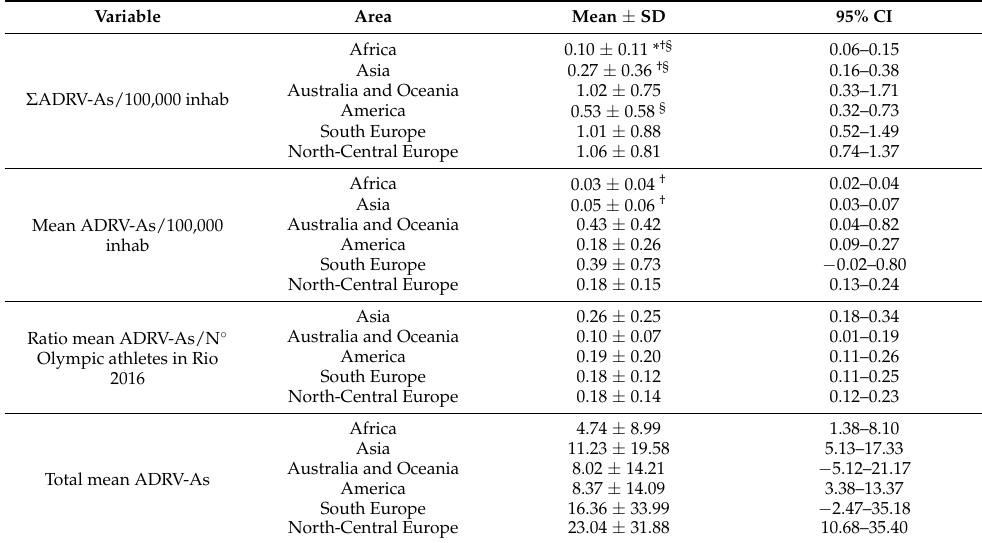
Table 1. Prevalence of ADRV-As by world areas between 2013 and 2018. Variable Area Mean ±